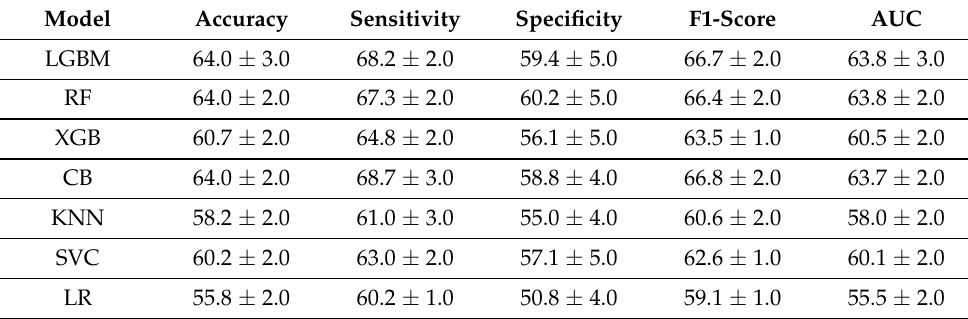
Table 2. Quantitative model performance metrics for the multimodal cases.